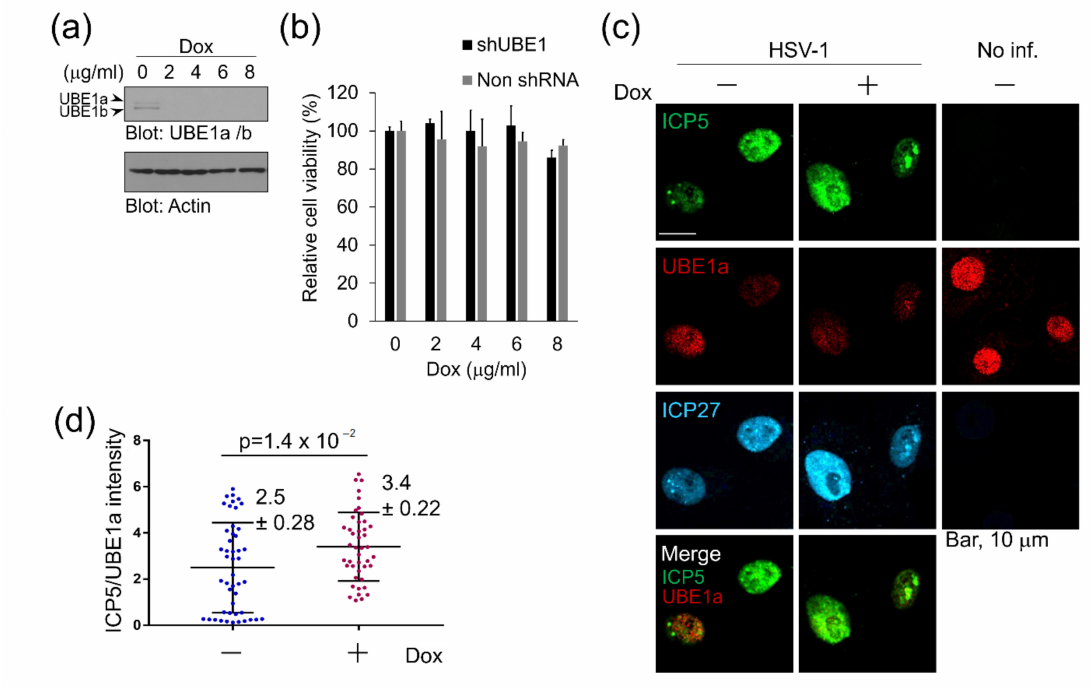
Figure 4. UBE1a knockdown by shRNA increased ICP5 expression in HSV-1 infected cells. ( a ) UBE1-knockdown by Dox-induced shRNA (shUBE1) against UBE1. Western blotting data showed the expression levels of UBE1a and UBE1b. Vero cells were transduced with or without lentivirus encoding Dox-inducible shUBE1, which downregulates both UBE1a and UBE1b. Transduced cells were treated with 0–8 µ g / mL Dox for 24 h, and cell lysates were analyzed by Western blotting, using a UBE1 antibody that recognized both UBE1a and UBE1b. ( b ) The cytotoxic e ff ect of Dox on Dox-inducible shUBE1-Vero cells. Cells were treated with 0–8 µ g / mL Dox and cultured for 24 h. The number of viable cells was evaluated by a cell viability assay. The values obtained from Dox-untreated cells were set as 100%. ( c ) UBE1 knockdown increased ICP5 expression in HSV-1 infected cells. Vero cells infected with or without HSV-1 were cultured with 6 µ g / mL Dox. At 8 hpi, cells were fixed and stained with anti-ICP5 (green), UBE1a (red), and ICP27 (cyan) antibodies. ( d ) The correlation of fluorescence intensity between UBE1a and ICP5 in infected cells after UBE1-knockdown. The means ± standard deviations are shown ( n = 47, 44 in each experiment). The y -axis is ICP5 intensity / UBE1a intensity calculated by using